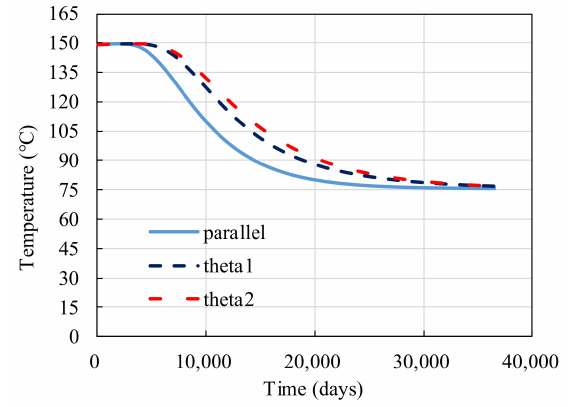
Figure 10. Effect of fracture orientation on thermal breakthrough.